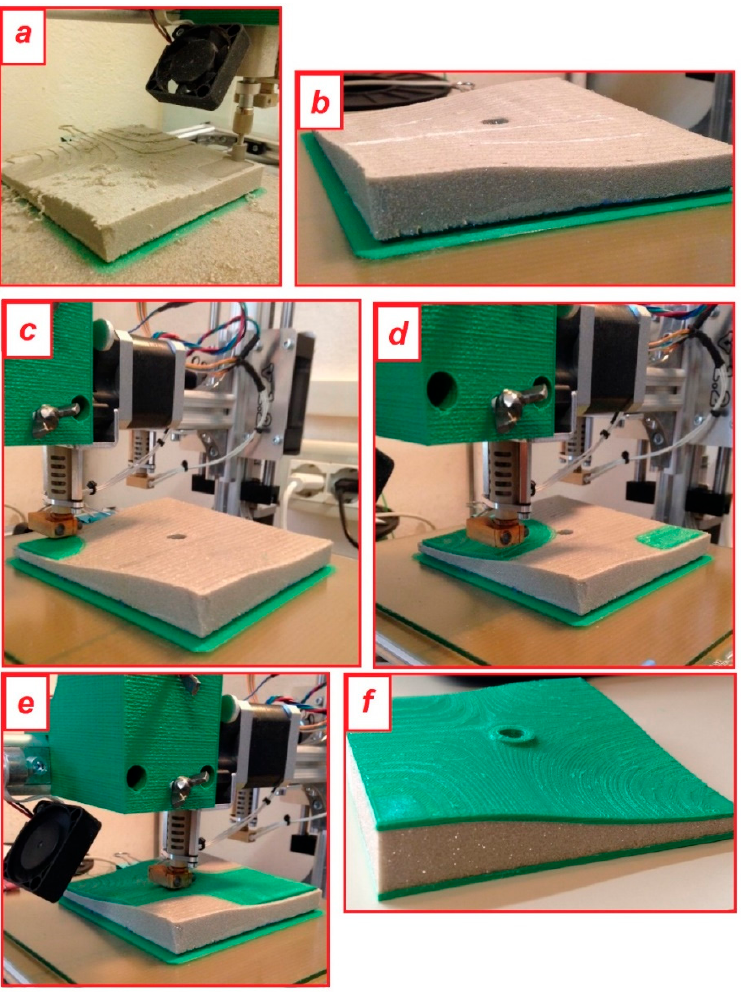
Figure 8. Photographic reportage of different steps to build the prototype of a sandwich structure